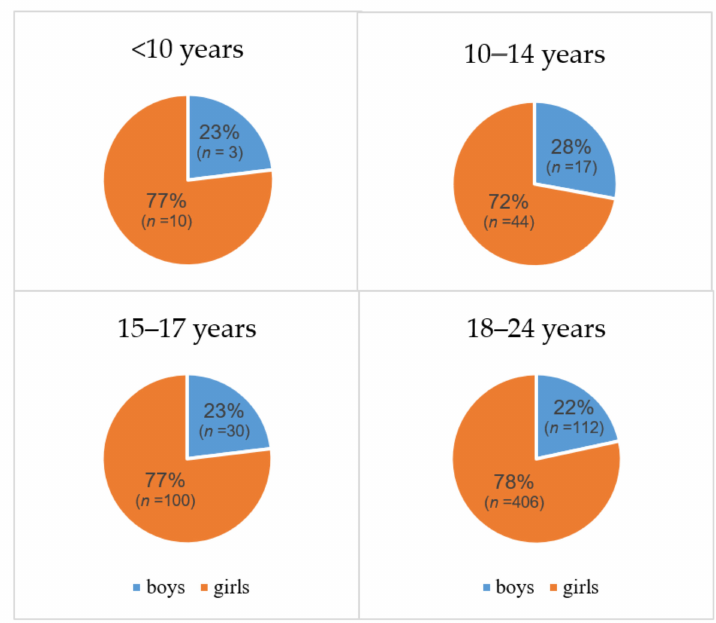
Figure 3. Sex distribution of differentiated thyroid carcinoma within different age groups in the Netherlands, 1990–2019. Sex distribution of differentiated thyroid carcinoma of the age groups <10, 10–14 years, 15–17 years, and 18–24 years. Both percentage and the absolute number of patients are